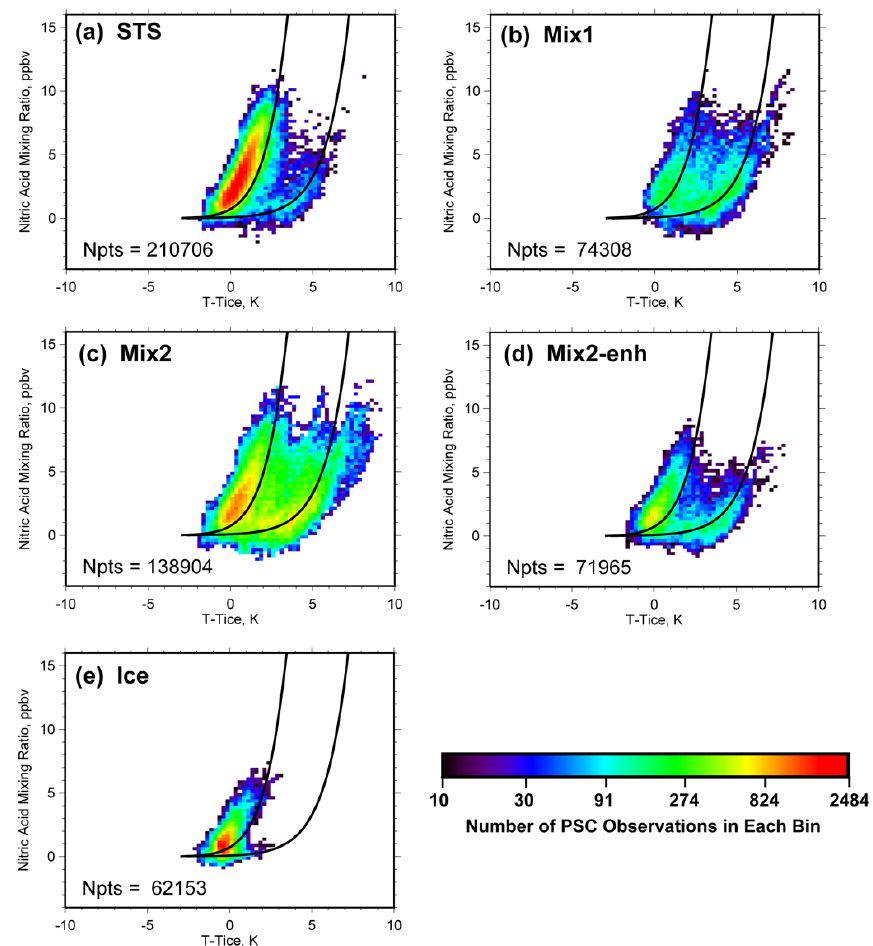
Fig. 3. Uptake of nitric acid as a function of T − T ice for CALIOP Arctic PSC observations at 490K potential temperature during 1 December 2009–31 January 2010 for (a) STS, (b) Mix 1, (c) Mix 2, (d) Mix 2-enh, and (e) ice clouds. The histogram bin size is 0.25ppbv × 0.25K and the color scale indicates the number of cloud observations falling within each bin. Black lines are reference equilibrium uptake curves for STS (left) and NAT (right) assuming 16ppbv HNO 3 and 5ppbv H 2